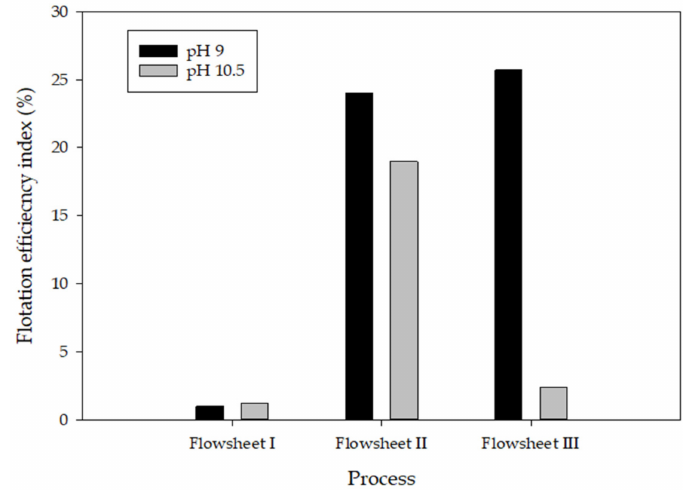
Figure 7. Flotation efficiency index of Flowsheets I–III.